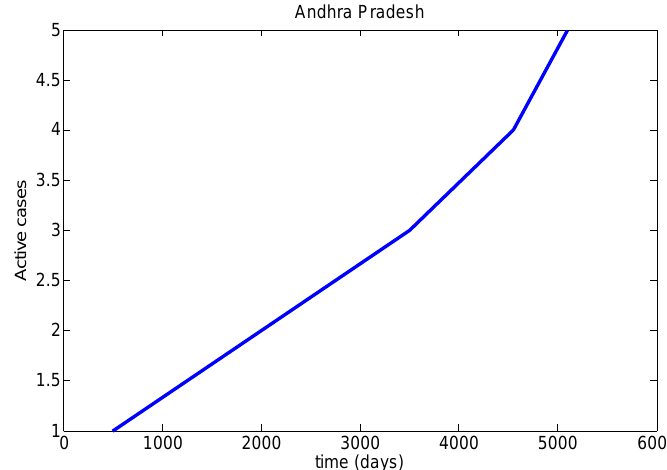
Figure 11. Active cases of Andhra Pradesh from real life